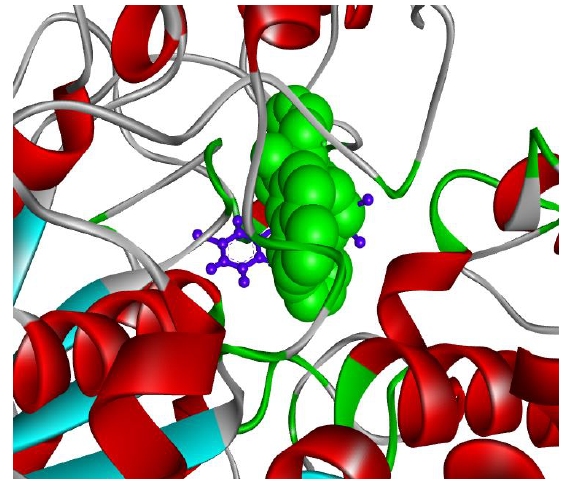
Figure 4: ‘Molecular overlay’ of the ‘top inhibitor’ bound to butyrylcholinesterase in conjunction with ‘5 HF’ (used as a reference molecule). The ‘top inhibitor’ and the ‘reference inhibitor’ are pre- sented in ‘ball & stick’ (blue) and CPK (green) styles, respectively.